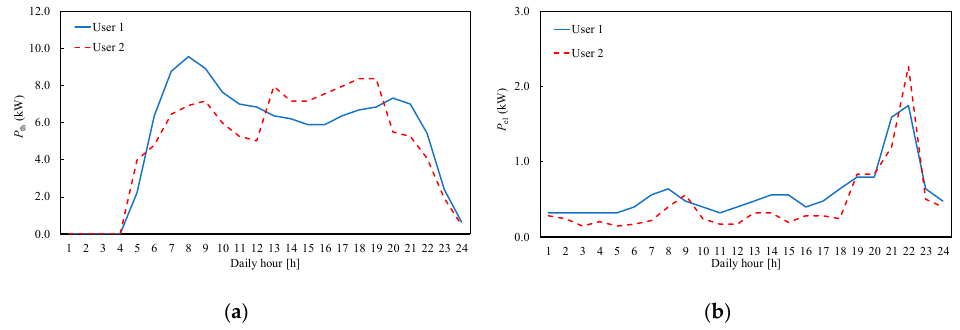
Figure 5. Daily power demand of two users: ( a ) thermal power, ( b ) electric power.